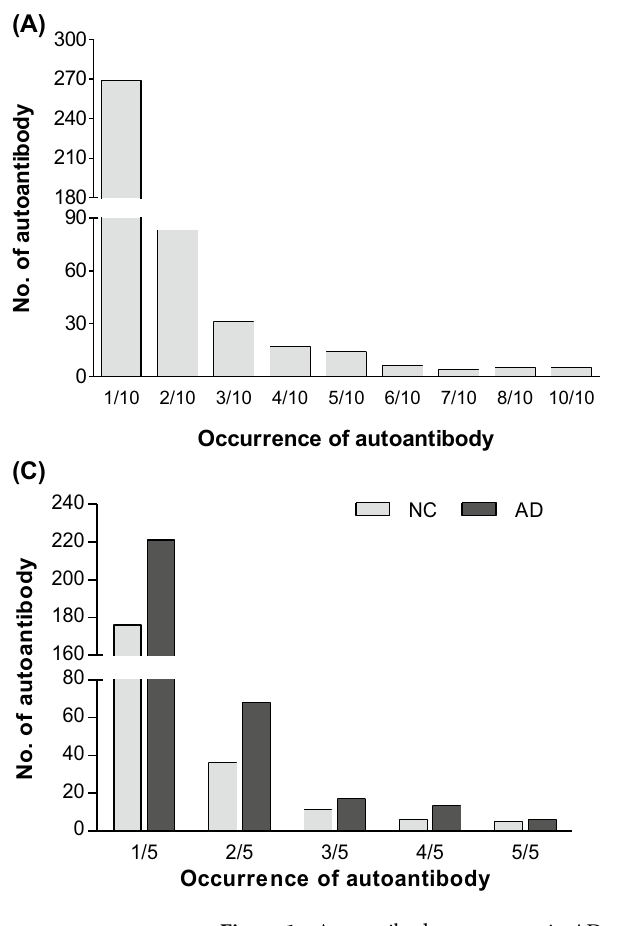
Figure 1. Autoantibody occurrence in AD patients (AD) and cognitively normal control subjects (NC). ( A ) Autoantibody occurrence in all tested subjects. Autoantibody occurrence indicates the frequency as to how many times a certain autoantibody is detected in 10 subjects of the discovery set. The most autoantibodies were detected in only one subject with an occurrence of 1/10. ( B and C ) Autoantibody occurrence in the individual AD and NC groups. Bars show mean ± standard deviation